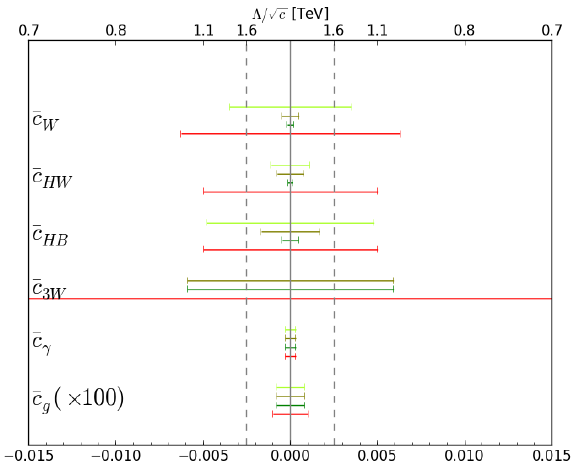
Figure 3 . The prospective sensitivities of CLIC measurements at 1.4 TeV to individual operator coe(cid:14)cients (green) and in a (cid:12)t marginalised over all contributing operators (red). The lightest green colour is for individual (cid:12)ts omitting both the HZ and W + W (cid:0) production cross-sections, those in olive green exclude HZ but include W + W (cid:0) , and the darkest green colour is for individual (cid:12)ts including both HZ and W + W (cid:0) .